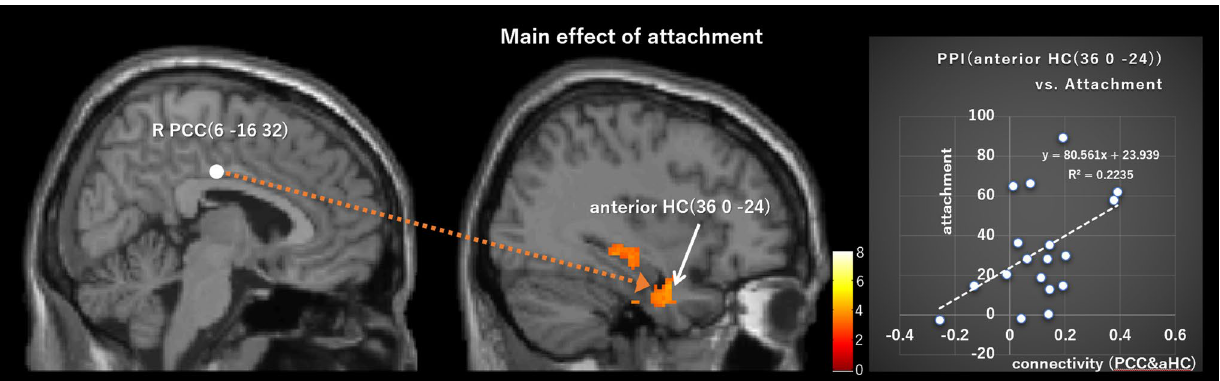
Figure 5. The right PCC (6, − 16, 32) showed a positive connectivity with the right anterior hippocampus (HC; 36, 0, − 24) in the main effect of attachment. The individual strength of connectivity between the right PCC (6, − 16, 32) and anterior HC (36, 0, − 24) in the main effect of attachment positively correlated with individual subjective awareness of